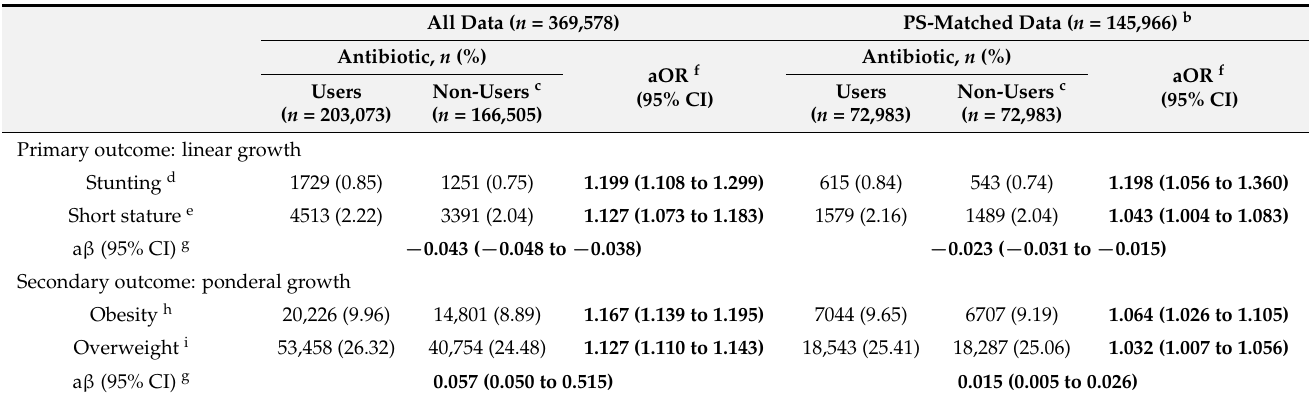
Table 3. Effect of antibiotic use on risk of linear growth and ponderal growth of preschool children in